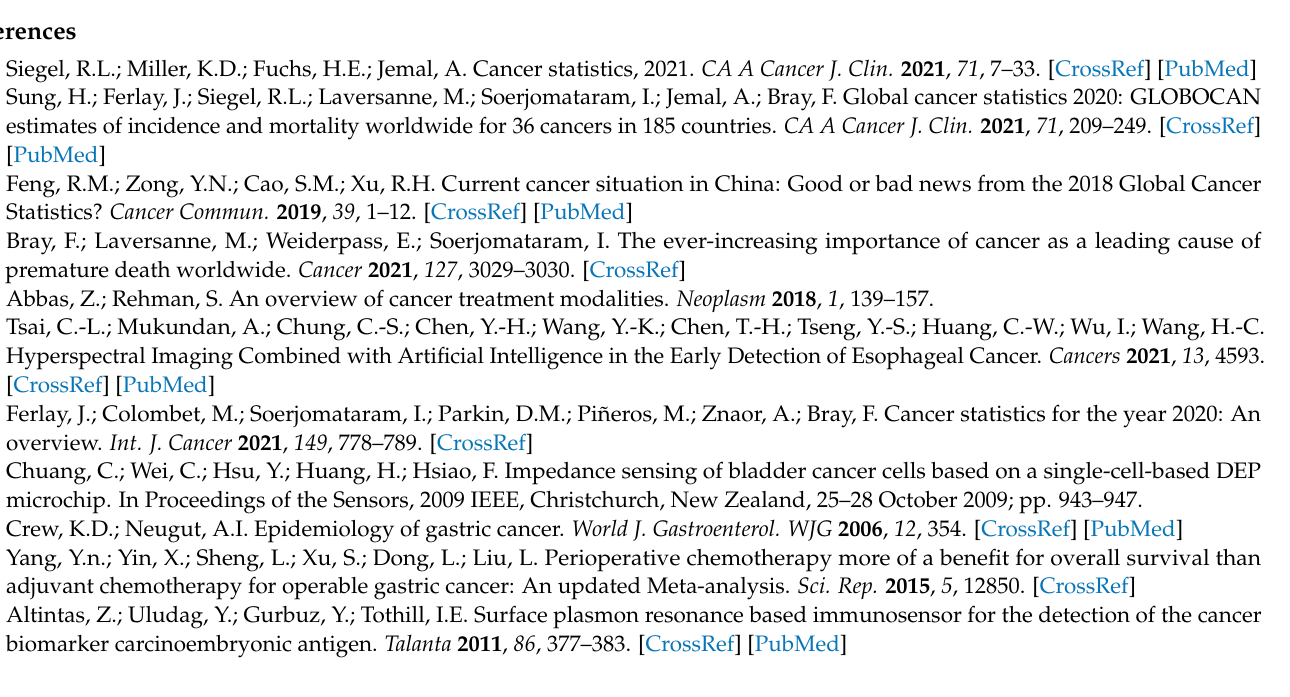
tem. Figure S2: Schematic of impedance measurement system. Figure S3: Schematic diagram of biosensor chip architecture. Figure S4: Schematic diagram of microelectrodes under OM. Figure S5: Flow chart of biosensor chip fabrication. Figure S6: Actual finished product of the biosensor chip. Figure S7: Schematic diagram of reparation of the different cells. Figure S8: The photoelectric flow measurement result of CE81T esophageal cancer cells under different cell numbers, among which, CE81T-1 is the first-stage cancer lesion and CE81T-4 is the fourth-stage cancer lesion. Figure S9: Under the microscope, live cells appear white, and dead cells appear blue. Table S1: Regression analysis of A549. Table S2: Regression analysis of TSGH-8301. Table S3: Regression analysis of CE81T-1/VGH. Table S4: Regression analysis of